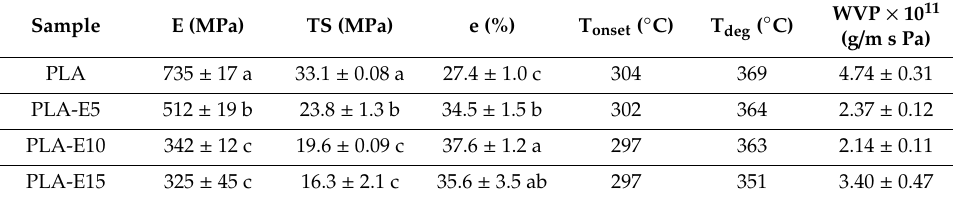
Table 3. Mechanical, thermal, and water vapor barrier parameters of PLA and PLA-based films.